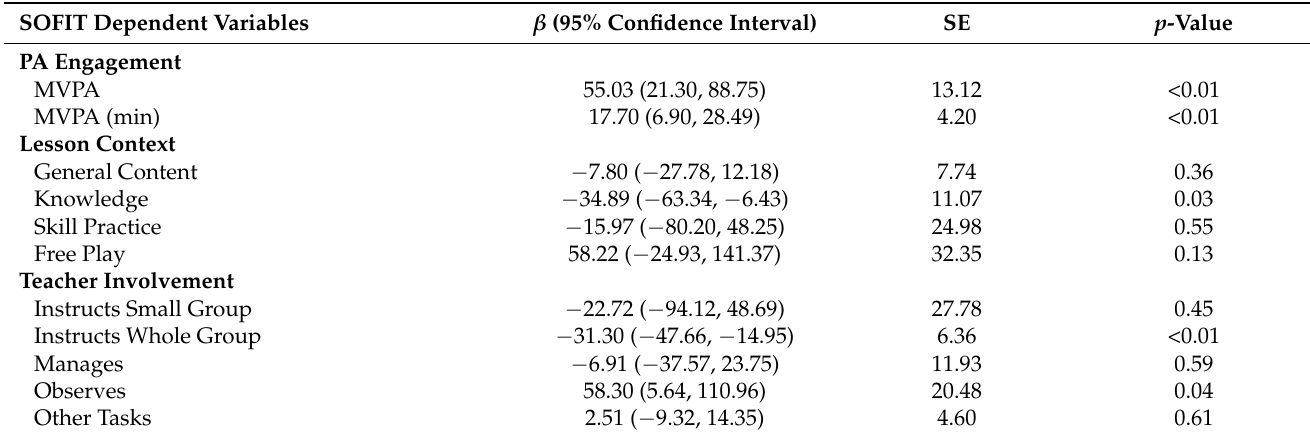
Table 2. Results of Individual Linear Regression Models Predicting Each SOFIT Variable by Instruc- tional Style (Flipped Learning vs. Direct Instruction